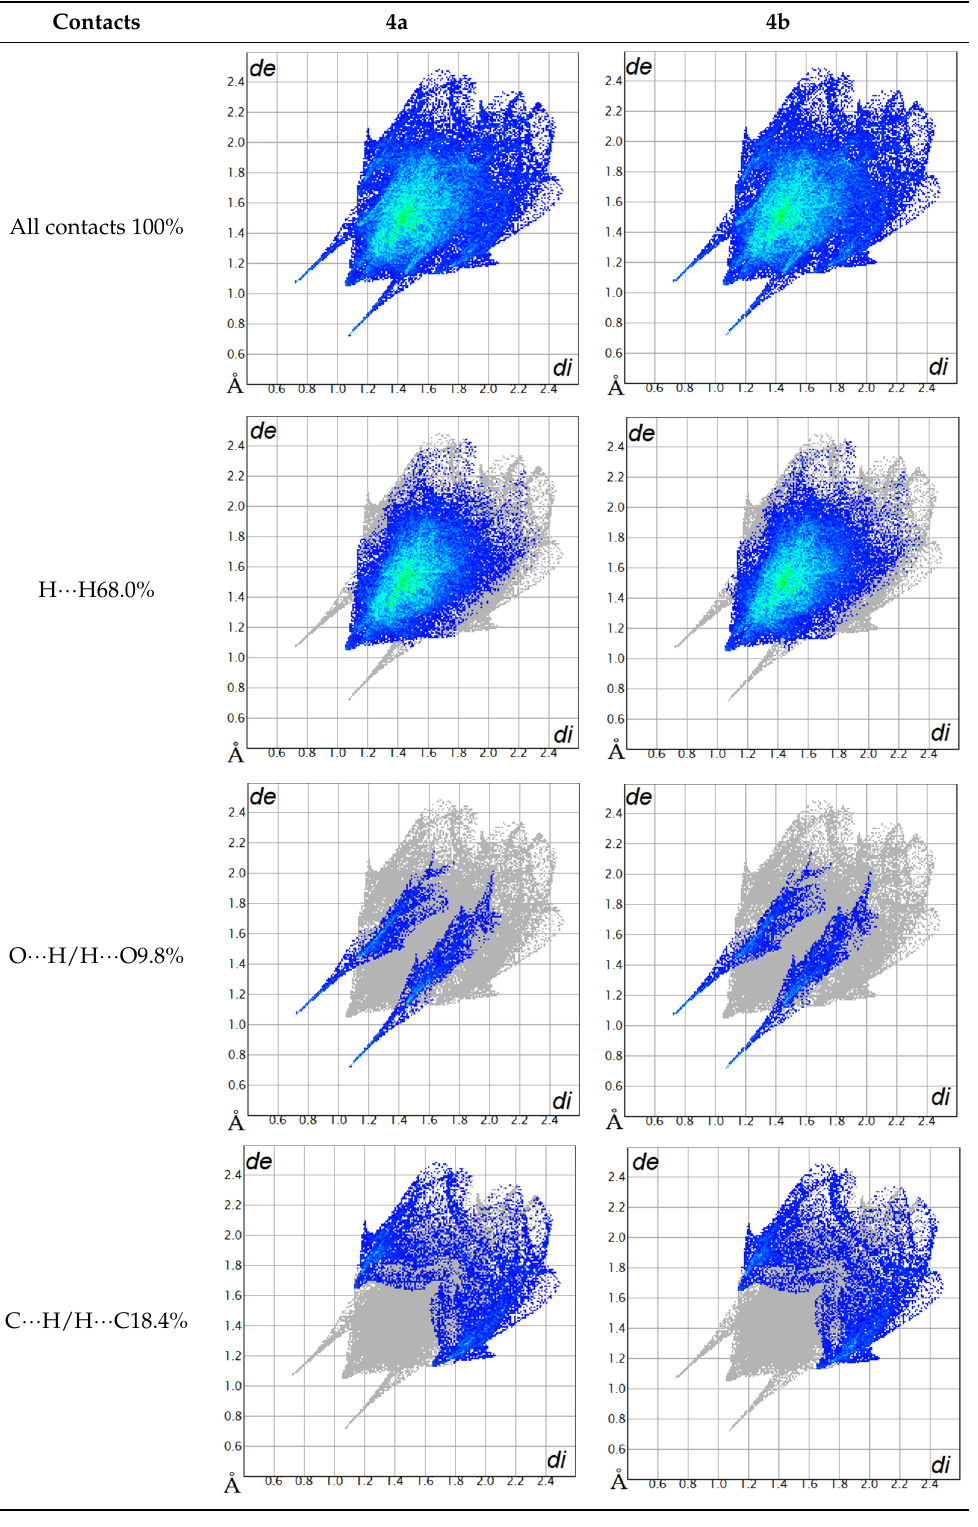
Figure 4. Hirshfeld surface of compounds 4a and 4b . Table 4. Two-dimensional fingerprint plots of compounds 4a and 4b .